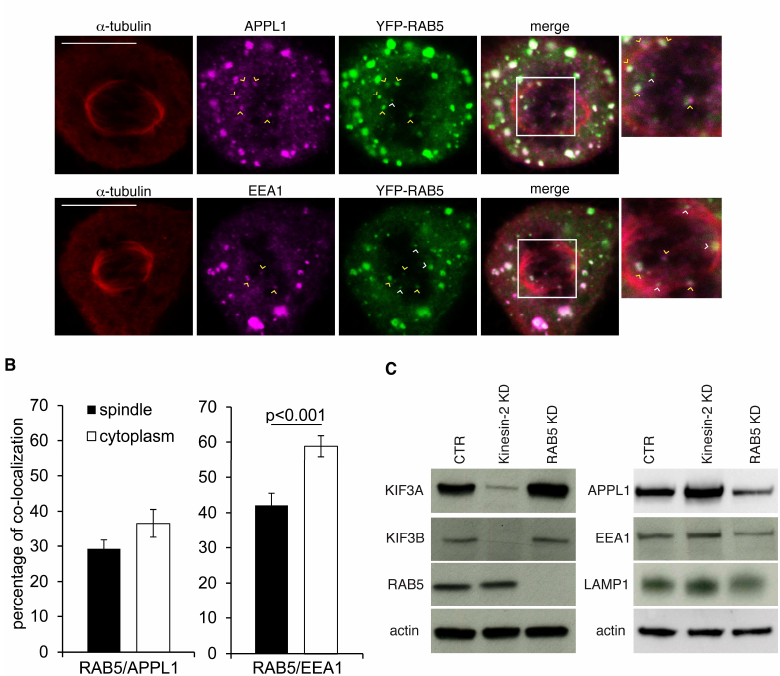
Figure 3. Most of the RAB5 vesicles associated with the spindle are APPL1 endosomes. ( A ) Confocal images of U2OS cells stably expressing YFP-RAB5 (in green) stained with α-tubulin (in red) and APPL1 (in magenta, top row) or EEA1 (in magenta, bottom row). Yellow arrowhead point to RAB5 vesicles associated with the spindle colocalizing with APPL1 or EEA1, white arrowheads to vesicles that do not colocalize. Insets on the right highlight the spindle region. ( B ) Bar graph representing the percentage of colocalization between RAB5 and either APPL1 or EEA1 within the spindle region or the cytoplasm. Twenty-nine cells per condition were analyzed from three independent experiments. Mean values ± SEM. ( C ) Total cellular lysates from U2OS cells silenced with control oligo (CTR), or KIF3A and KIF3B oligos (Kinesin-2 KD), or RAB5 oligos were immunoblotted as indicated on the